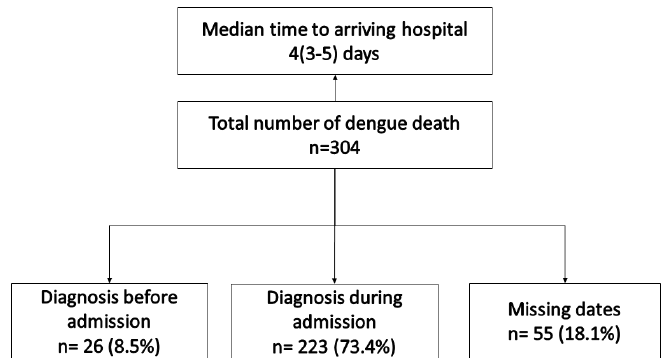
Figure 1. Timing of dengue diagnosis in relation to hospital admission among dengue deaths reported to the national programme in Myanmar